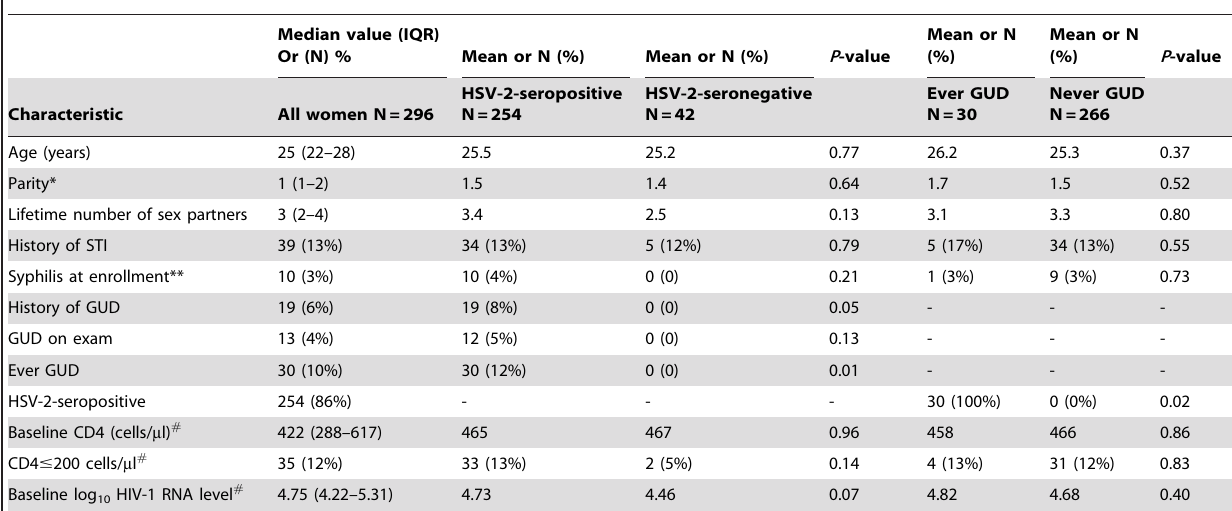
Table 1. Characteristics of HIV-1 Infected Women at Enrollment, and by HSV-2 Antibody Status or